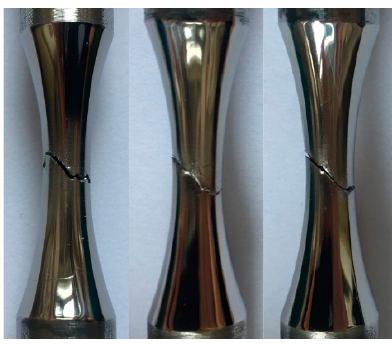
Figure 6. Fractography after the fatigue test.